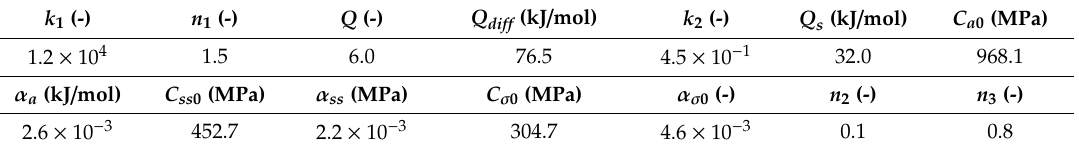
Table 4. Material constants in the developed model for heating and hardness.